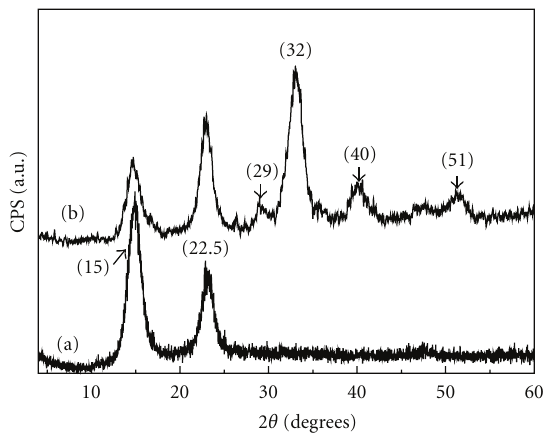
Figure 2: X-ray di ff raction patterns of the BC (a) and BC-HA nanocomposites (b). The characteristic HA peaks are indexed at the top for BC-HA.